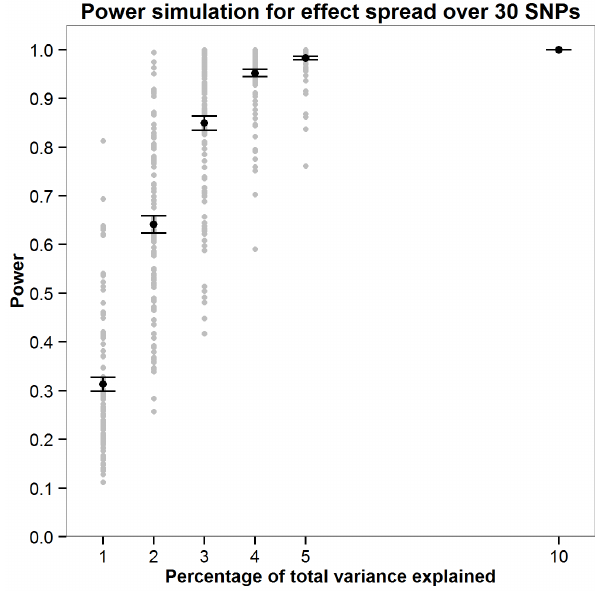
Figure 2. Simulations exploring how power fuctuates as a function of total variance explained when the effect is spread over 30 SNPs. For each effect size (1,2,3,4,5 or 10% of the total variance) 100 simulations were carried out. The mean power from these 100 simulations is shown in red with error bars depicting 6 1 standard